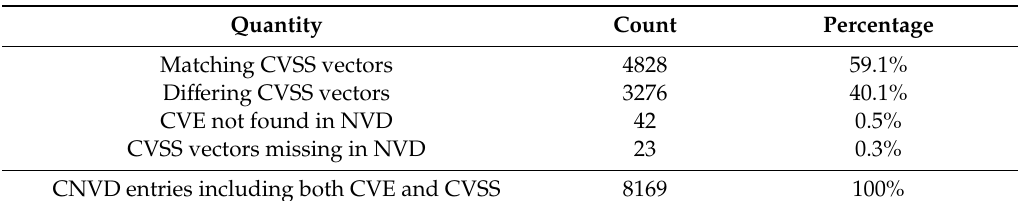
Table 6. CNVD and NVD CVSS vectors compatibility, checked for a subset of IoT-related CNVD entries that include CVSS scores and CVE